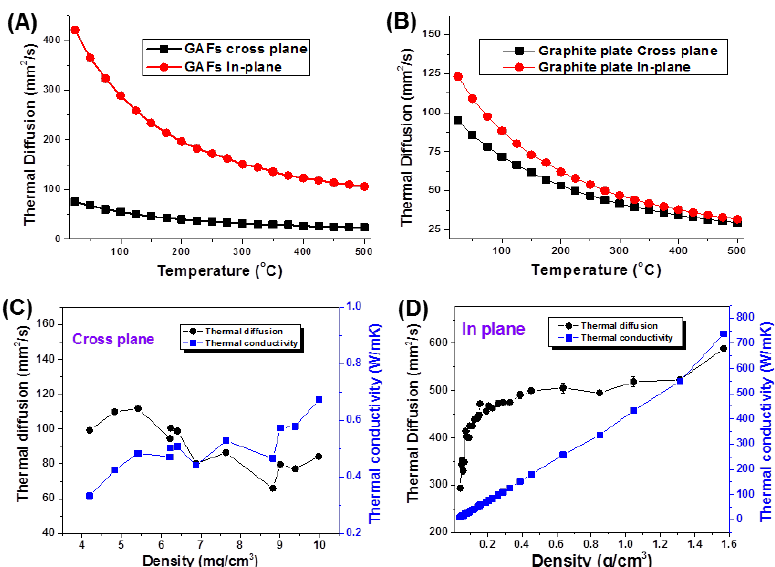
Figure 5. In-plane and cross-plane thermal diffusivity vs. temperature for typical ( A ) GAFs and ( B ) compressed graphite plates. The cross-plane ( C ) and in-plane ( D ) thermal diffusivity, thermal conductivities vs. densities for GAFs.